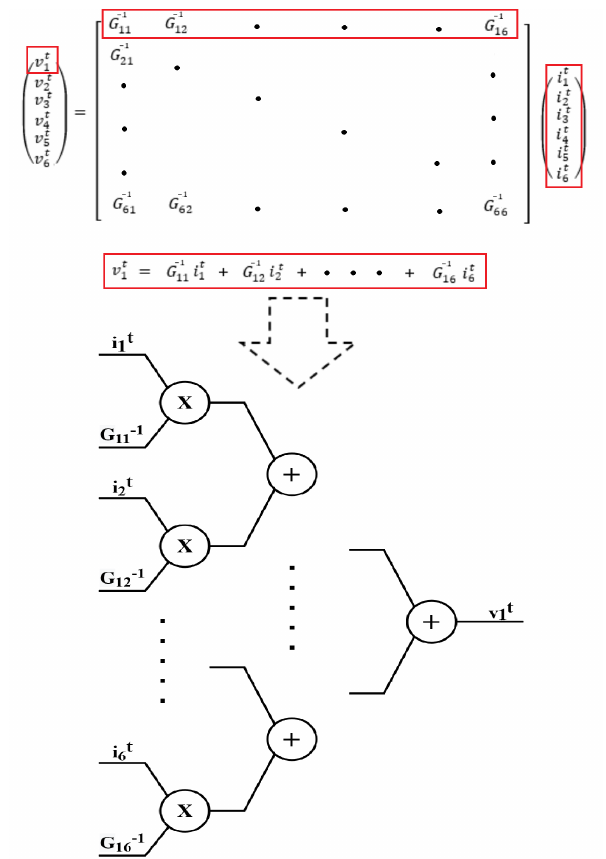
Figure 20. Conversion of equations to hardware